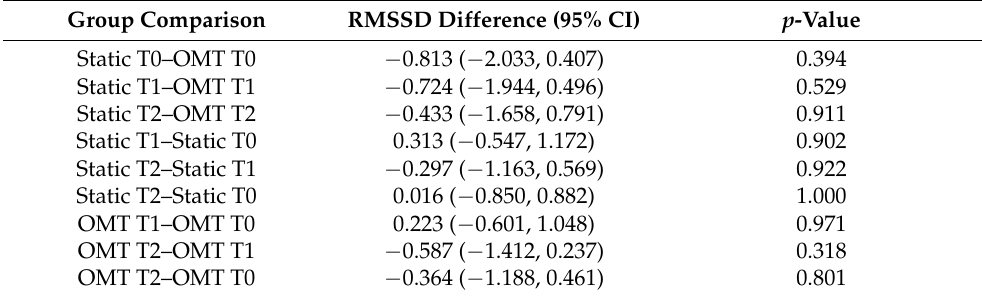
Table 3. Tukey post hoc tests regarding RMSSD.